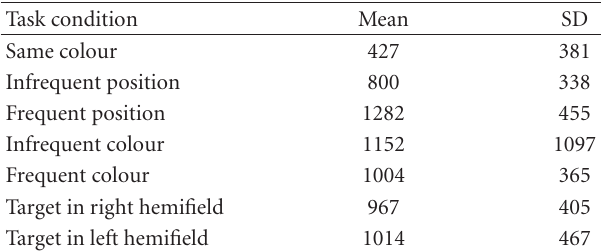
Table 3: Reaction time (ms) for each task condition, for incorrect